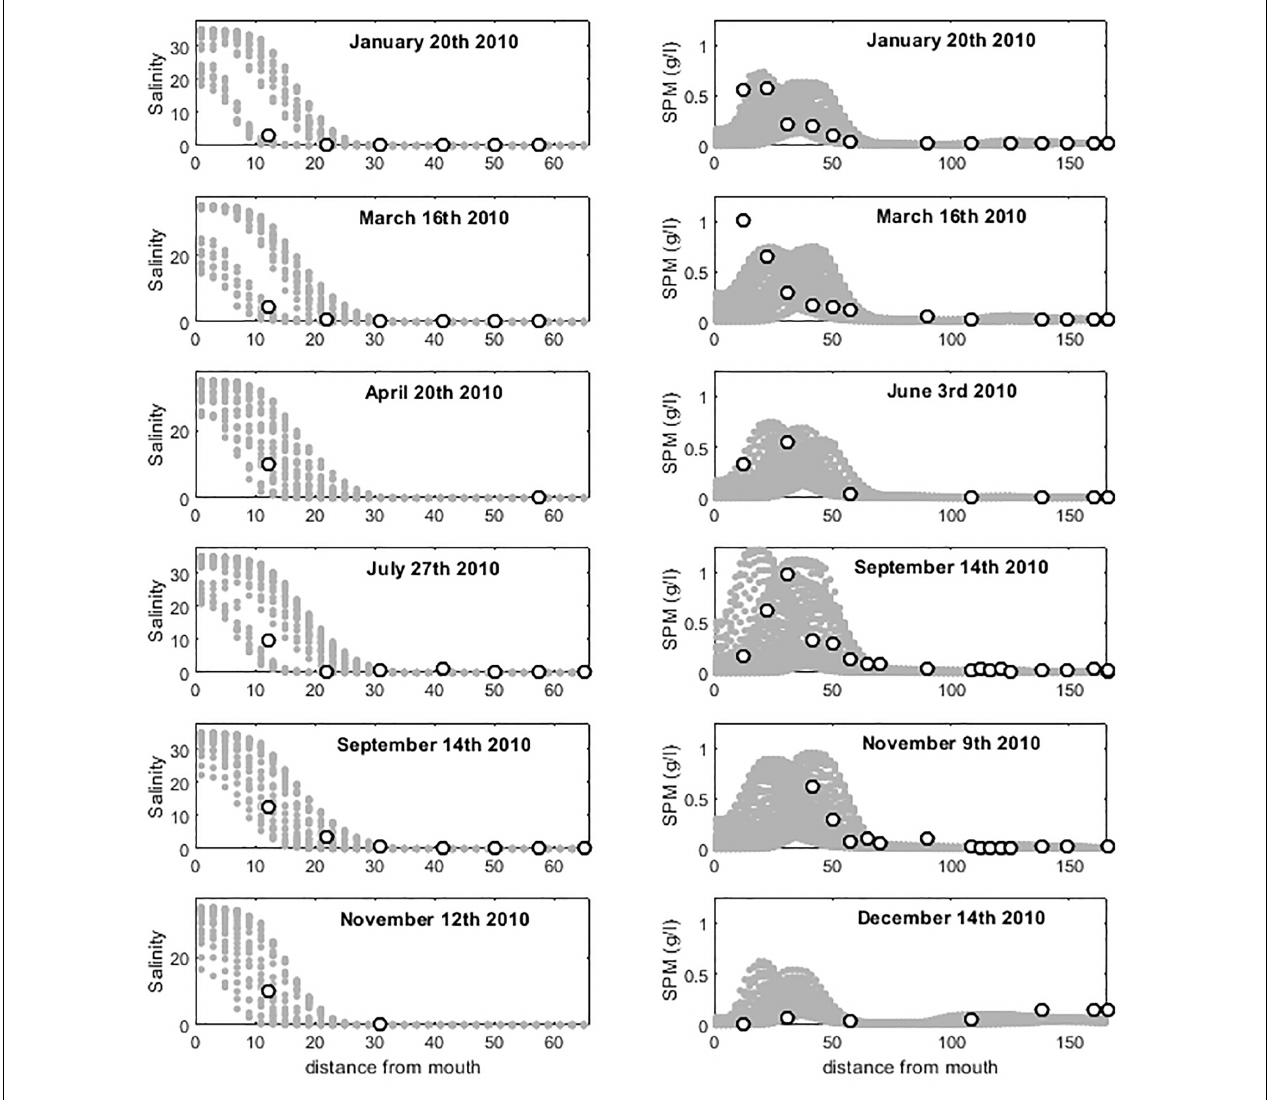
FIGURE 5 | Salinity (left) and SPM profiles (right) along the Seine estuary for 6 dates. White dots correspond to measurements, gray dots correspond to simulated values over 2 tidal cycles for salinity and 20 for